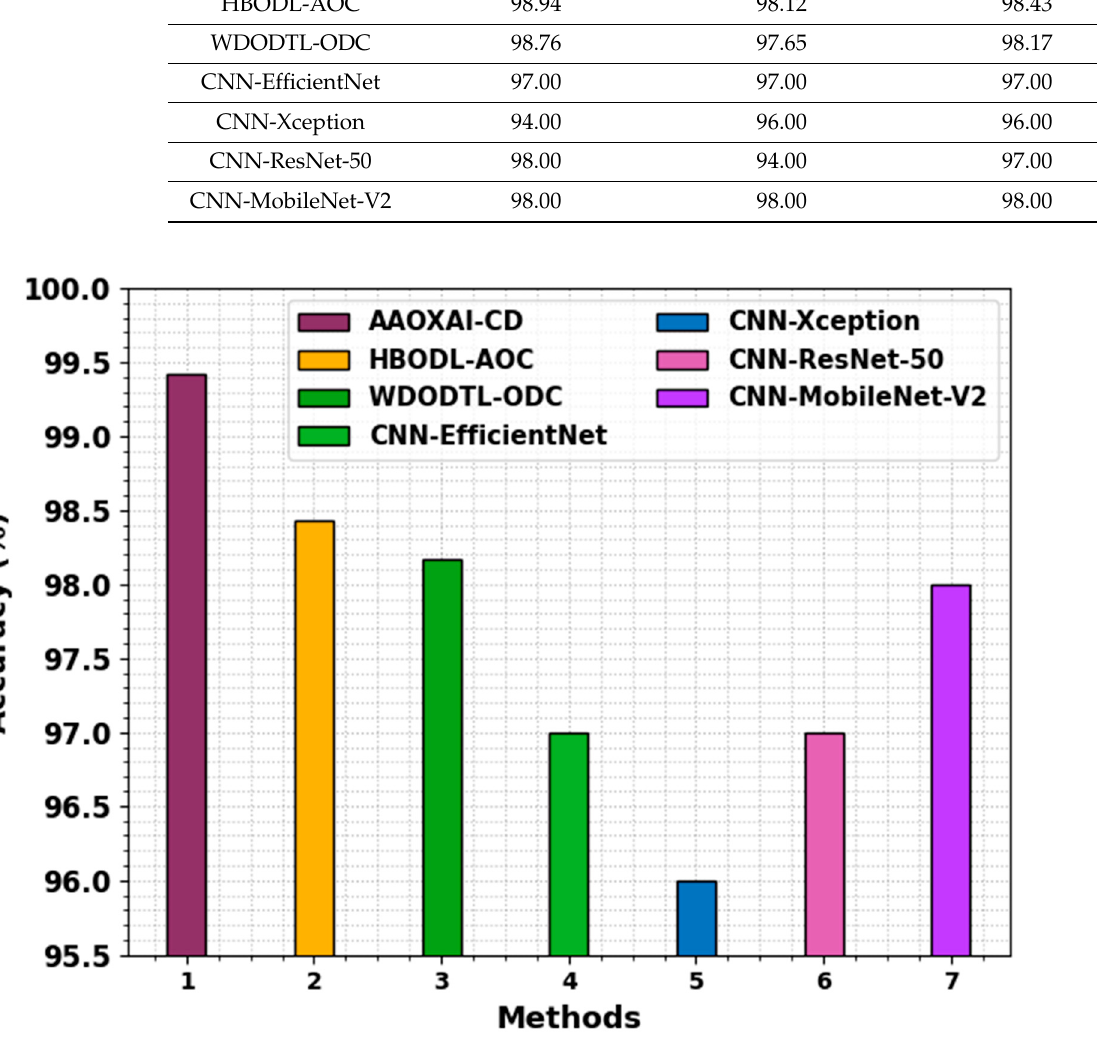
Figure 13. Comparative analysis of the AAOXAI-CD approach on dataset-2.